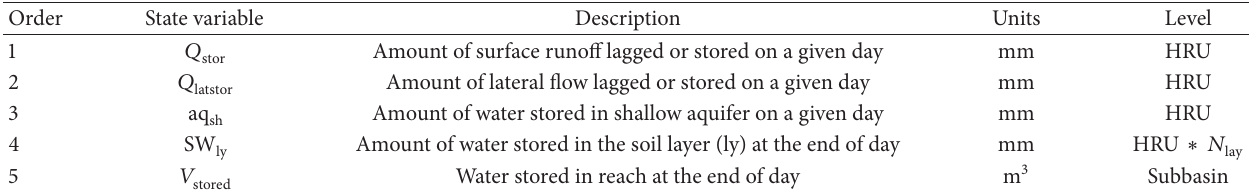
Table 2: State variables in SWAT model chosen for correlation